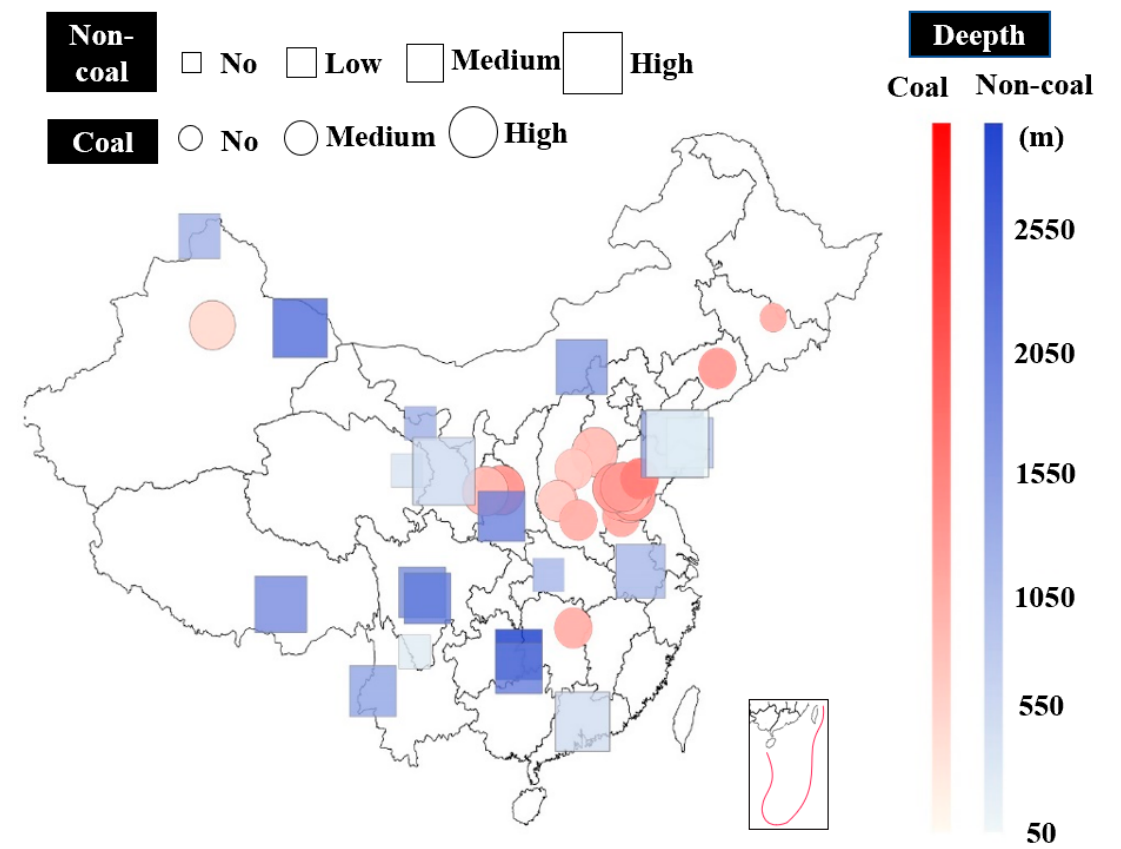
Figure 1. Distribution of rockburst tendency degrees of rocks in China (the darker the color, the deeper the buried depth, and the bigger the symbols, the stronger the rockburst).